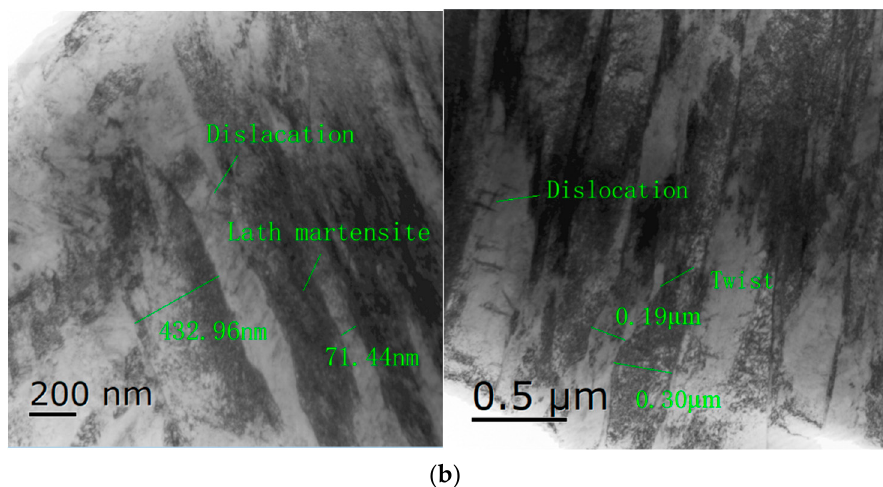
Figure 2. Transmission observation map; ( a ) Morphology before laser hardening. ( b ) Representative martensite image after laser hardening.